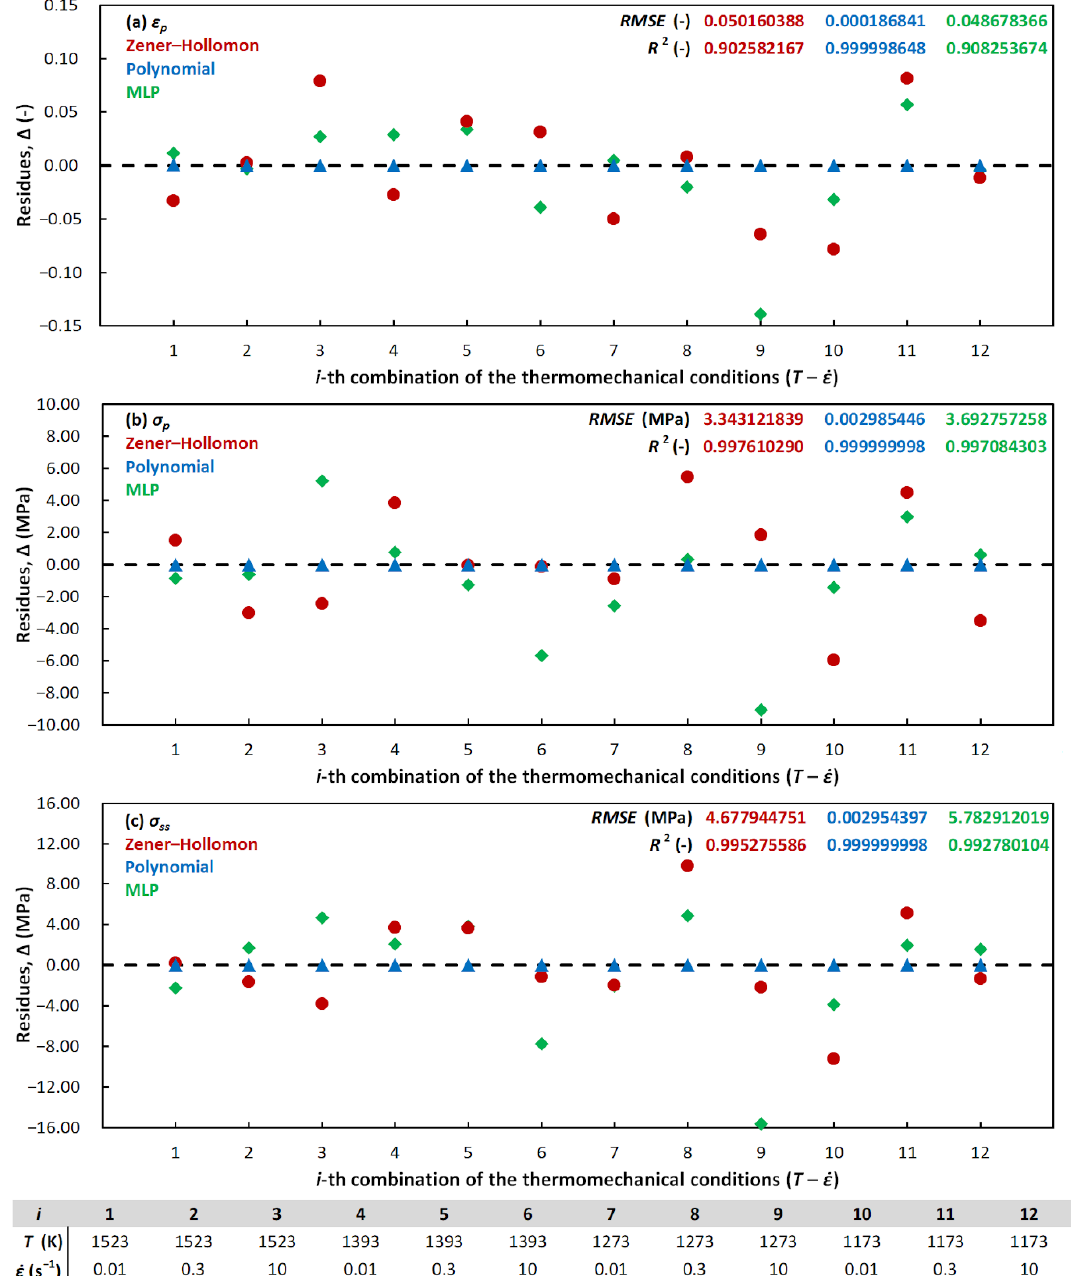
Figure 5. Residues after the peak and steady-state approximation. ( a ) Peak strain approximation; ( b ) peak stress approximation; ( c ) steady-state stress approximation. The red circles—Zener–Hollomon approach; The blue triangles—multivariate polynomial approach; The green diamonds—multi-layer perceptron approach.